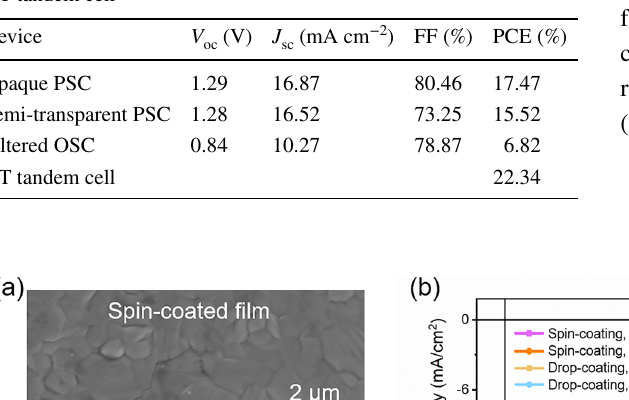
Table 3 Performance data for opaque and semi-transparent CsPbI